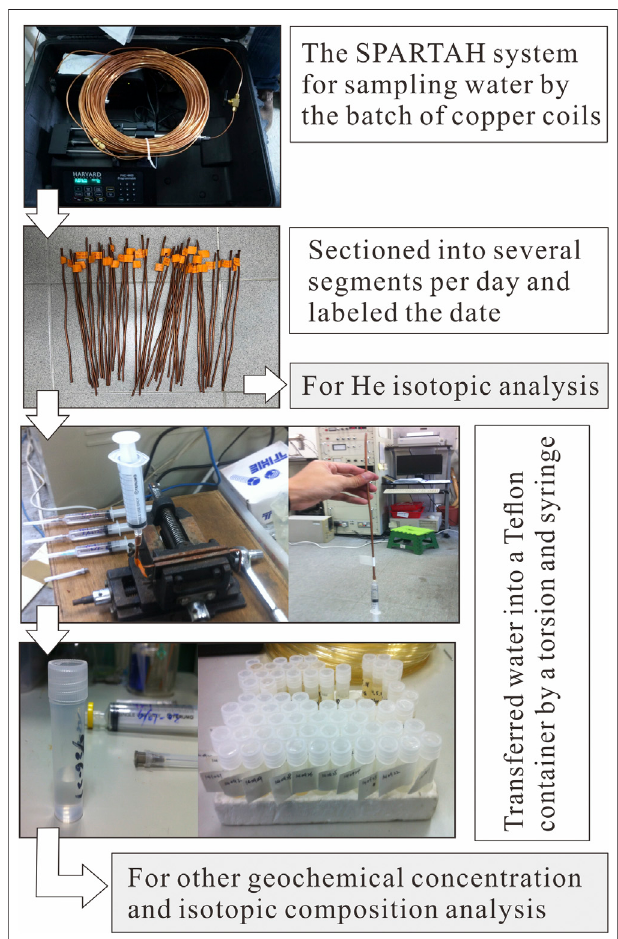
FIGURE 3 | The fl owchart of the methodology illustrating the sampling and procedure used for analysis in water samples through the SPARTAH